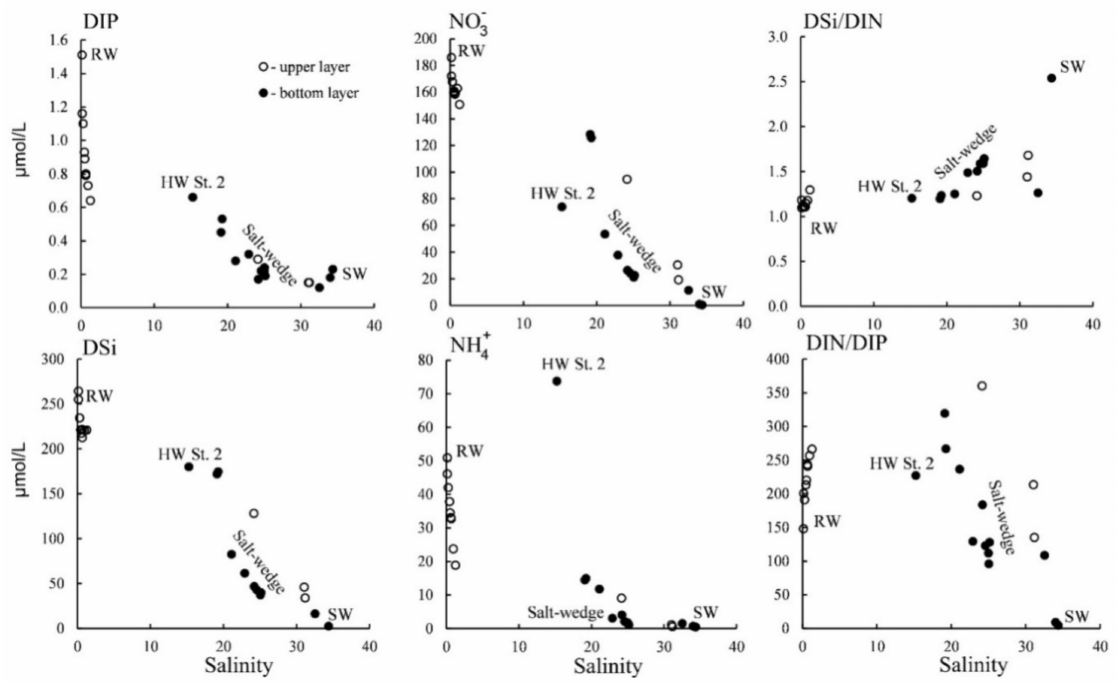
Figure 11. Nutrient concentration vs. salinity in near-bottom and surface water layers. 23 Feb. 2022 RW: river water, SW: seawater, HW: hypoxia water with low oxygen